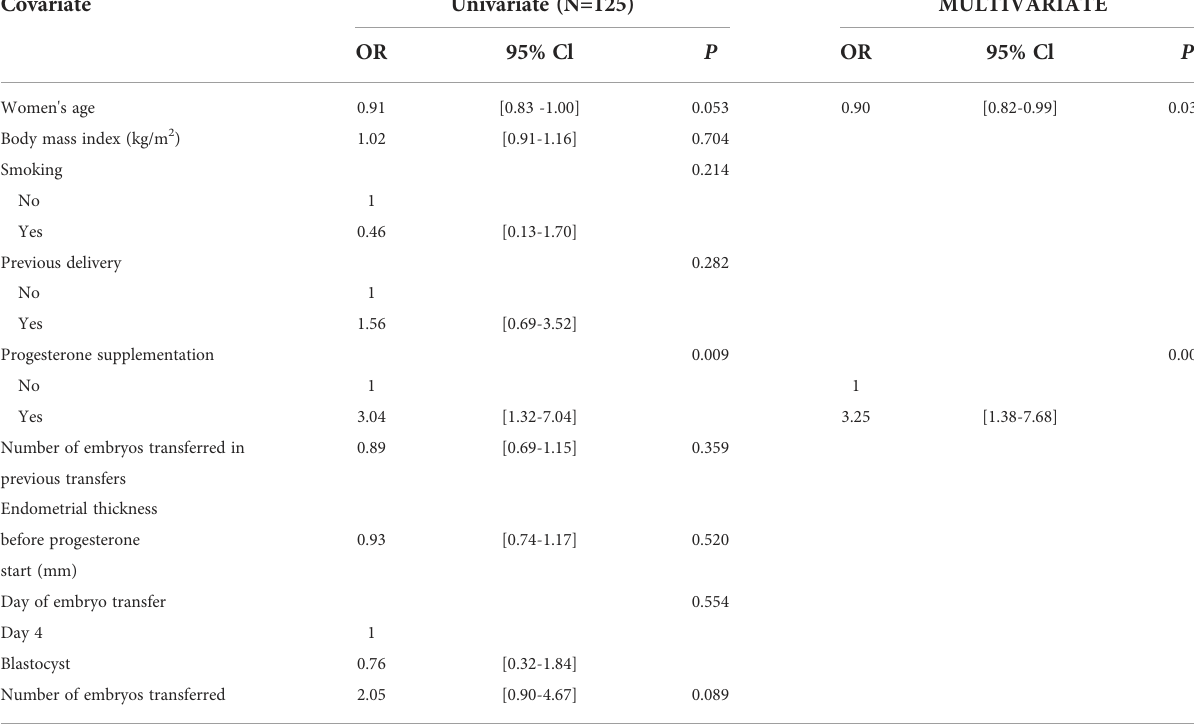
TABLE 3 Logistic regression analysis to identify factors associated with ongoing pregnancy rate. Covariate Univariate (N=125)